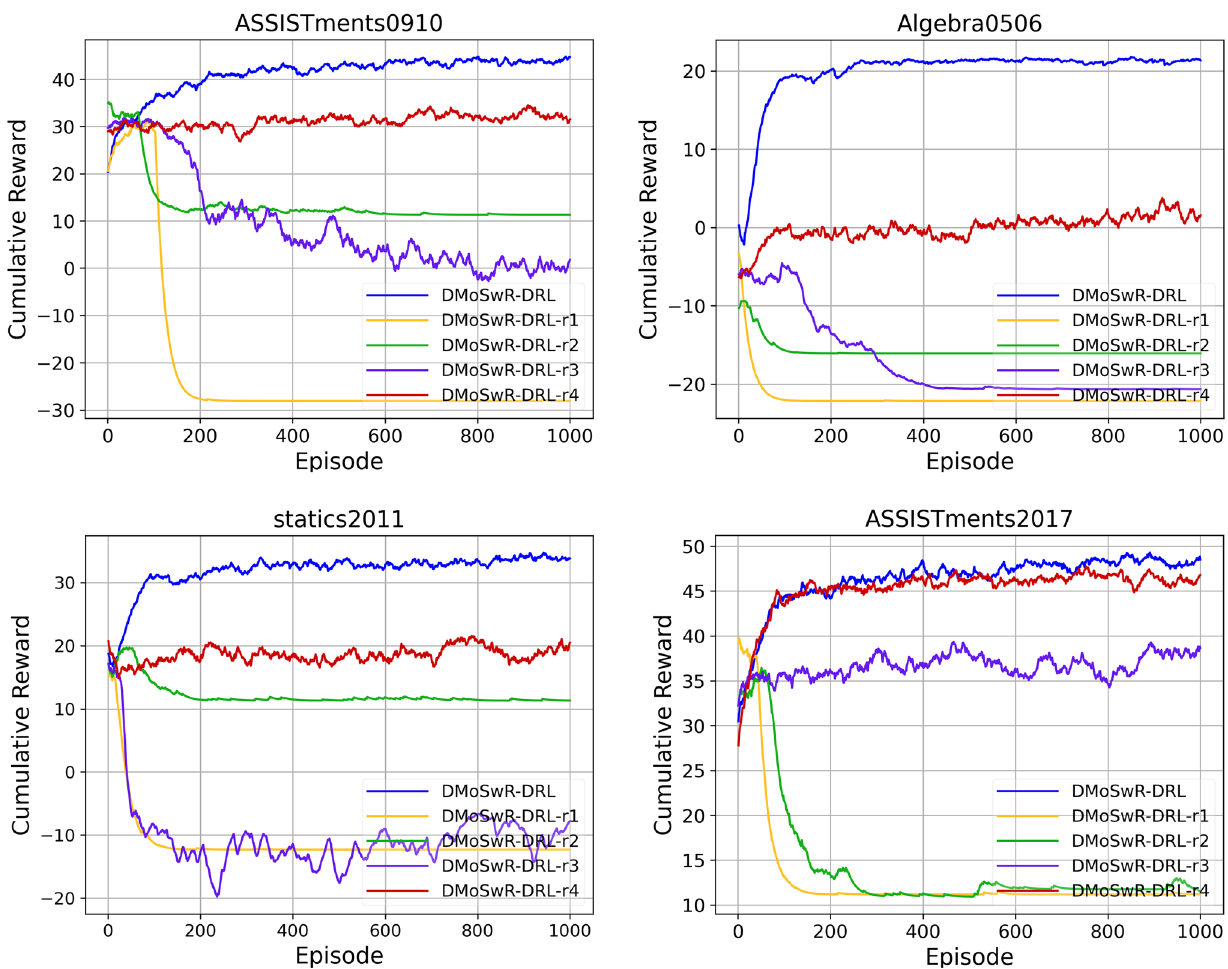
Fig. 12 The variant analysis of DMoSwR-DRL